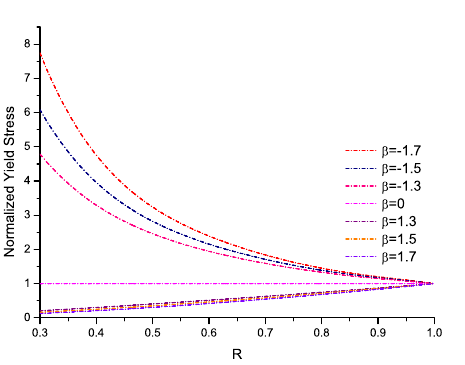
Figure 15: Distribution of normalized yield stress along radial direc- tion for different values of β